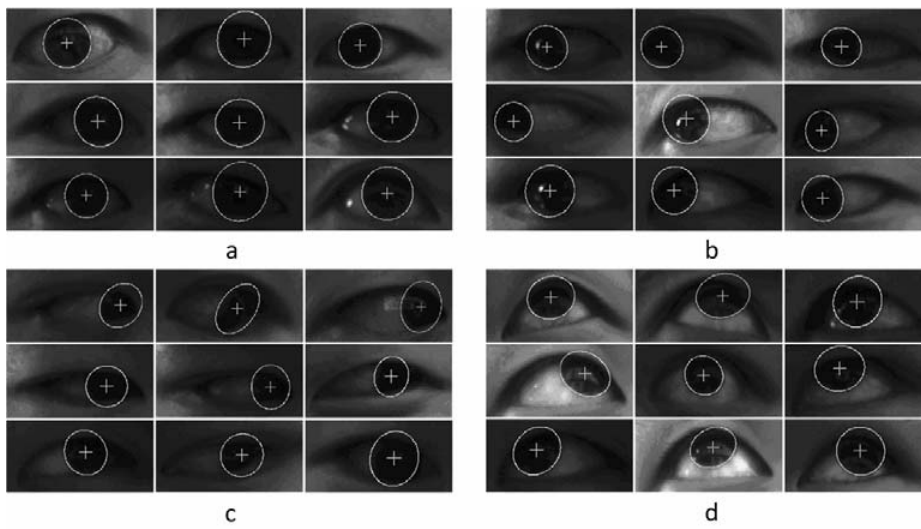
Figure 17: Successful examples of iris center detection corresponding to four states: (a) Center, (b) Left, (c) Right, (d) Upper. fitting. Figure 16d shows the accuracy result is better than Thirdly, when the eye looked in the upward direction, the second case. Especially, the accuracy is just 6.9% the upper edge of iris would be hidden under the upper lower than the first case when =0.05 T eyelid of eye. In general, this case is easier to handle than the second case, because enough points on the lower edge of both sides of the iris can still be obtained for ellipse